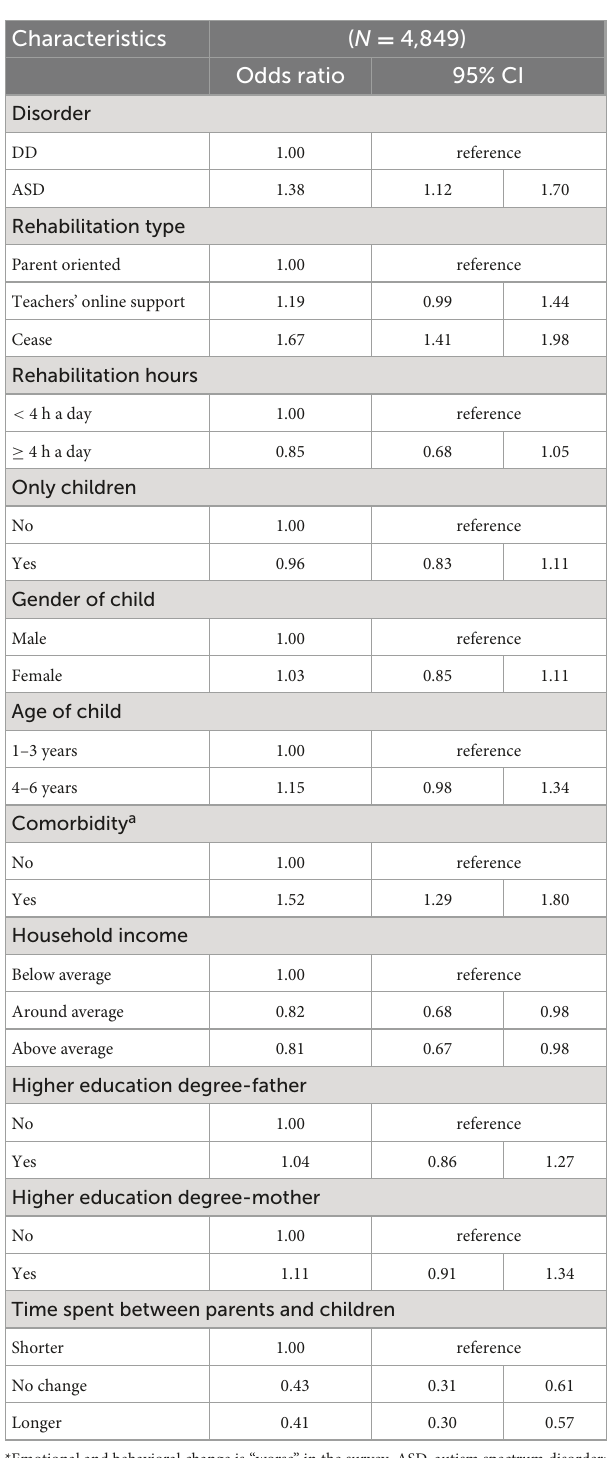
TABLE 2 The changes of children and parents after the outbreak of COVID-19.